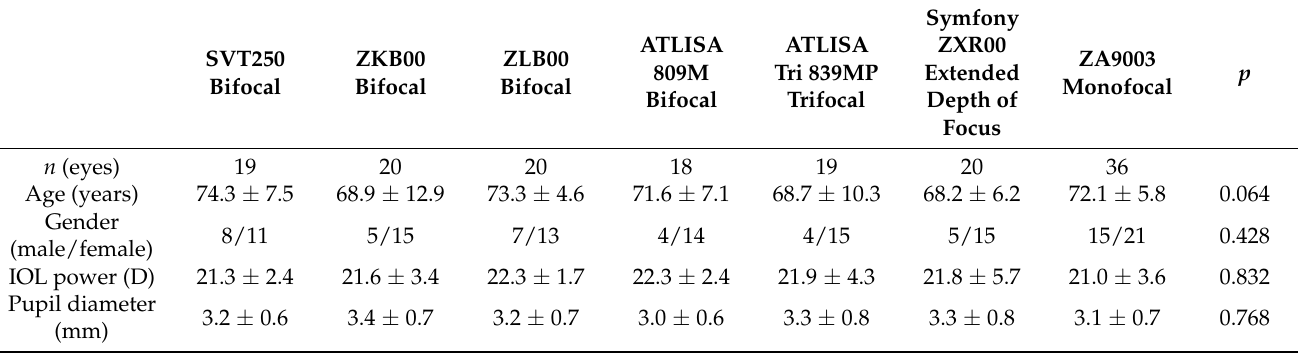
Table 2. Demographic data for each lens type. Results are displayed as mean ± standard deviation (SD) or frequency (gender), with the outcome of the ANOVA or the Kruskal–Wallis tests ( p -value). Pupil diameter was measured under photopic conditions. Lens power and pupil diameter correspond to the right